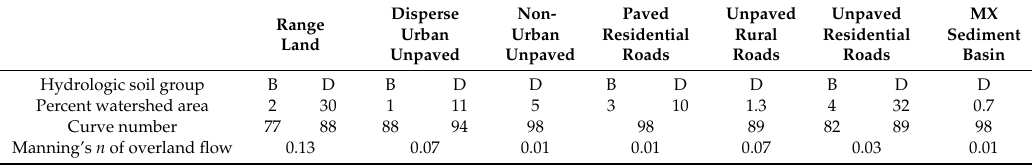
Table 2. Final AnnAGNPS runo ff parameters values used to calibrate runo ff .